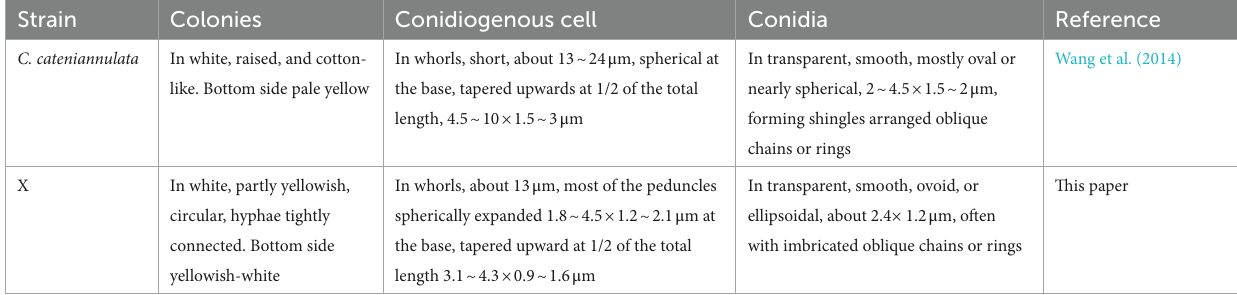
TABLE 1 Morphological comparison between strain X and C. cateniannulata.